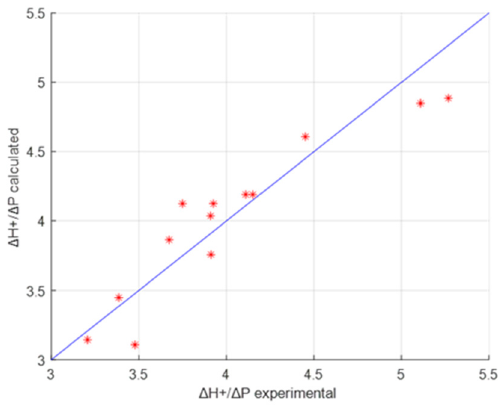
Figure 7. Comparison of the experimental ( * ) and calculated values of y = Δ H+/ Δ P for Ülgase sample by model 2.